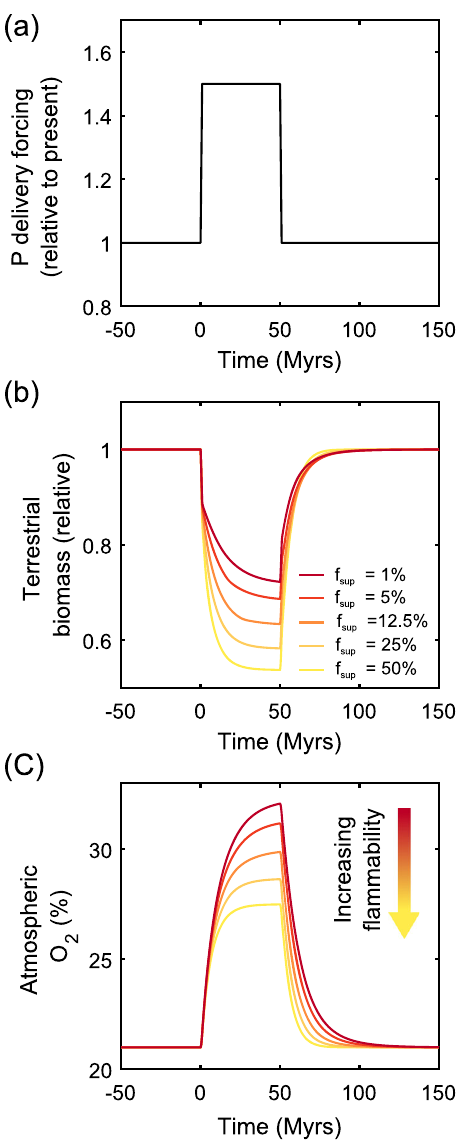
Fig. 4 Model perturbation response for varied fi re suppression ratios. Suppression ratio is the assumed increase in global terrestrial NPP under the complete absence of fi res, indicative of overall biosphere fl ammability. a Model is forced by increasing the delivery rate of nutrient phosphate by 50% for a 50 Myr period. b Relative terrestrial biomass. c Modelled atmospheric oxygen mixing